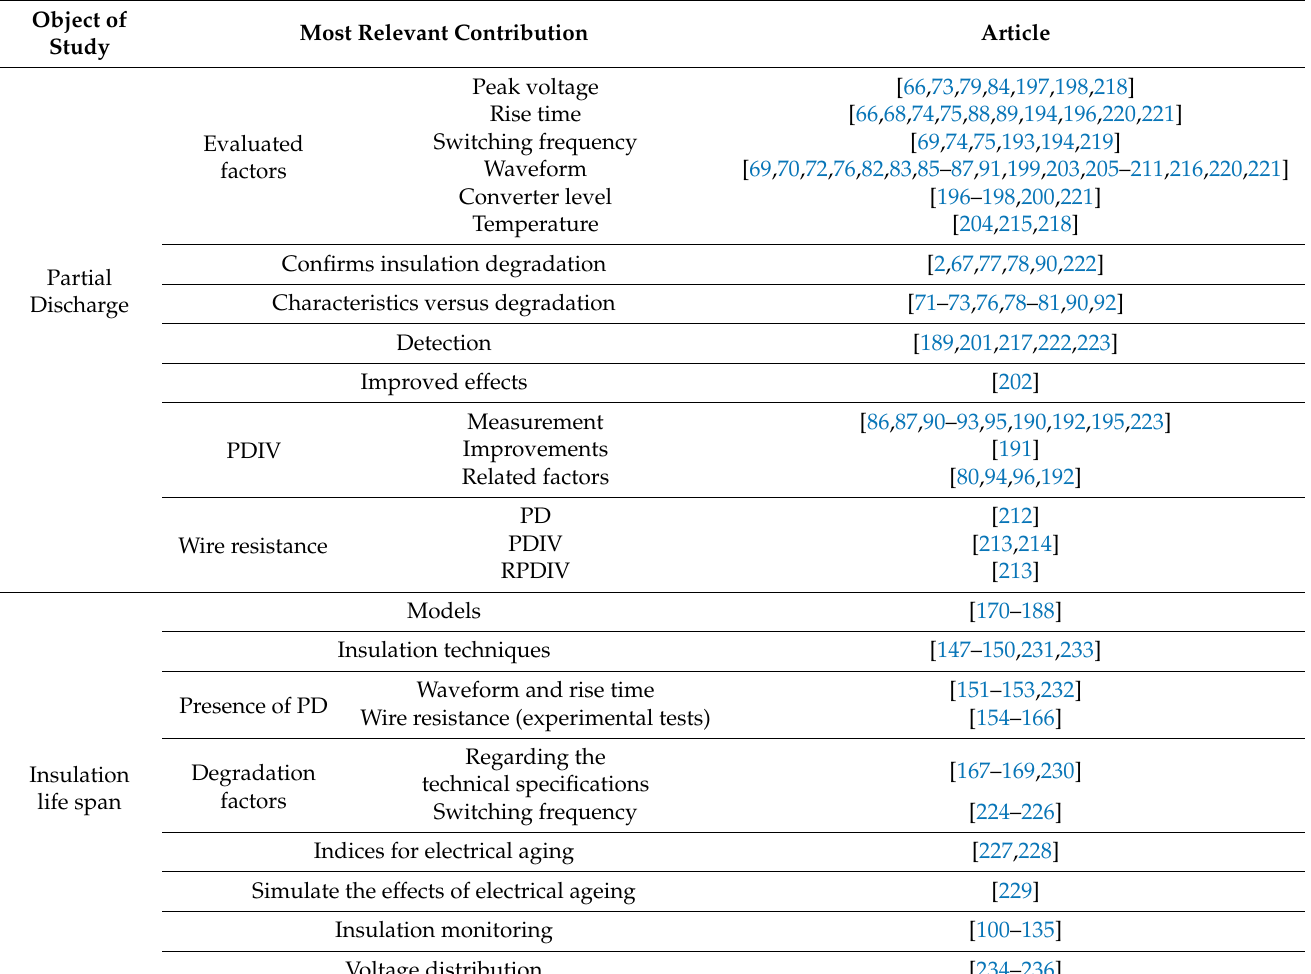
Table 8. Main contributions of each